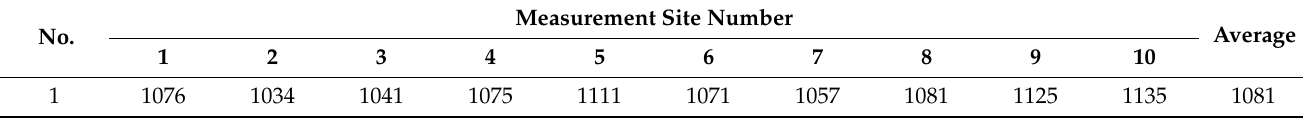
Table 5. Results of measurements of HV30 hardness of the sintered carbide insert of the pick for roadheaders (Figure 12a). No.